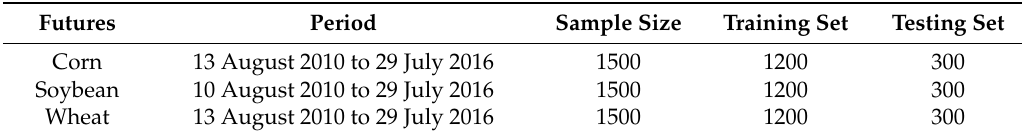
Table 1. Period and length of the three futures